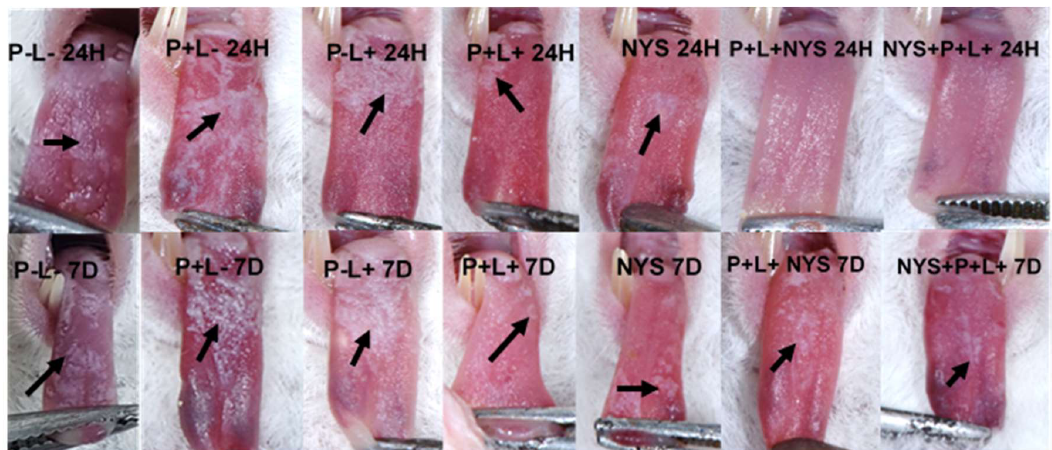
Figure 4. Representative images of the white or pseudomembranous patches (arrows) on the dorsum of the back of the tongue of animals from the P-L-, P + L-, P-L + , NYS and P + L + groups after 24 h and 7 days of treatment and the absence of tongue lesions of the animals submitted to the P + L + NYS and NYS + P + L + , after 24 h of treatment.